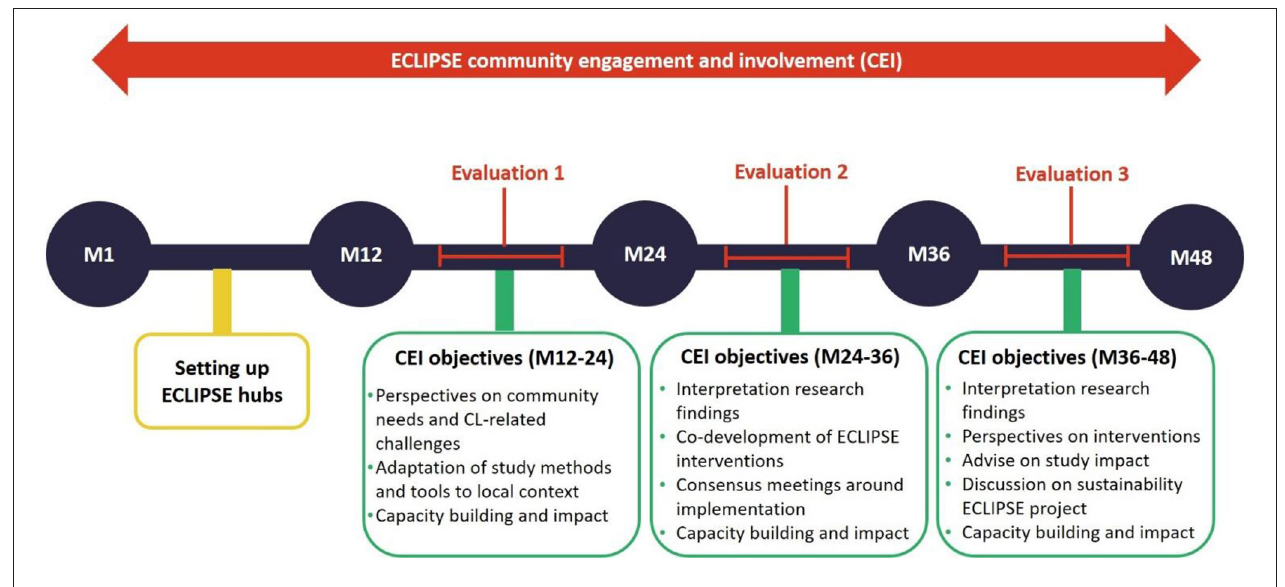
FIGURE 2 | Timeline of ECLIPSE community engagement and